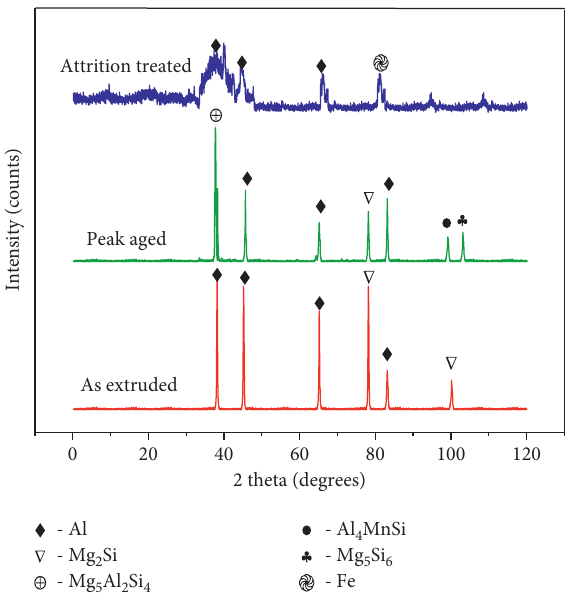
Figure 3: XRD profiles of the 6351 Al